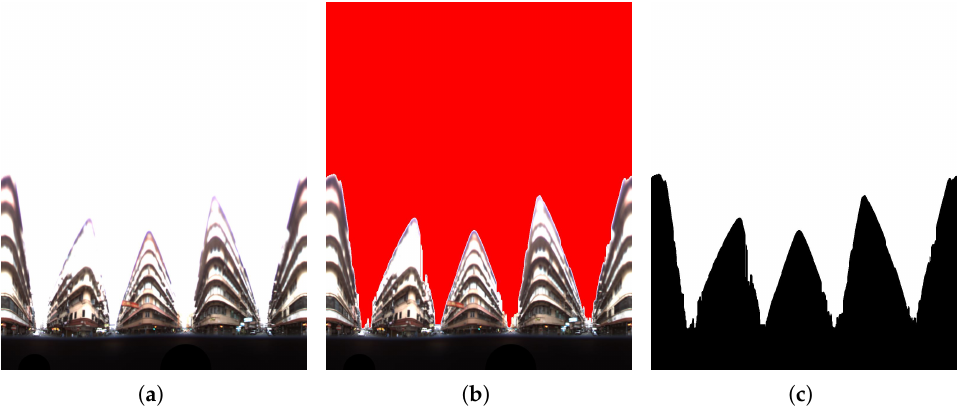
Figure 6. Results of sky region detection. ( a ) Image after rectification. ( b ) The sky region shown in red. ( c ) The sky region and non-sky region in the binarized